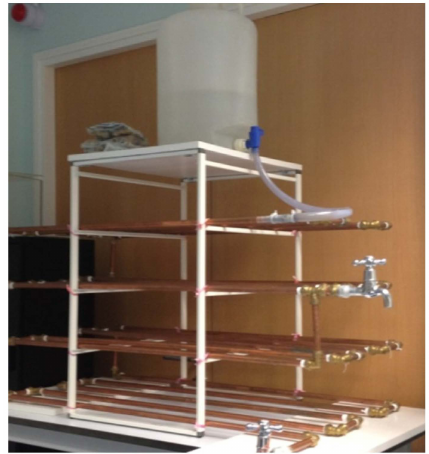
Figure 1. Photograph of the simulated lead-free premise plumbing system.